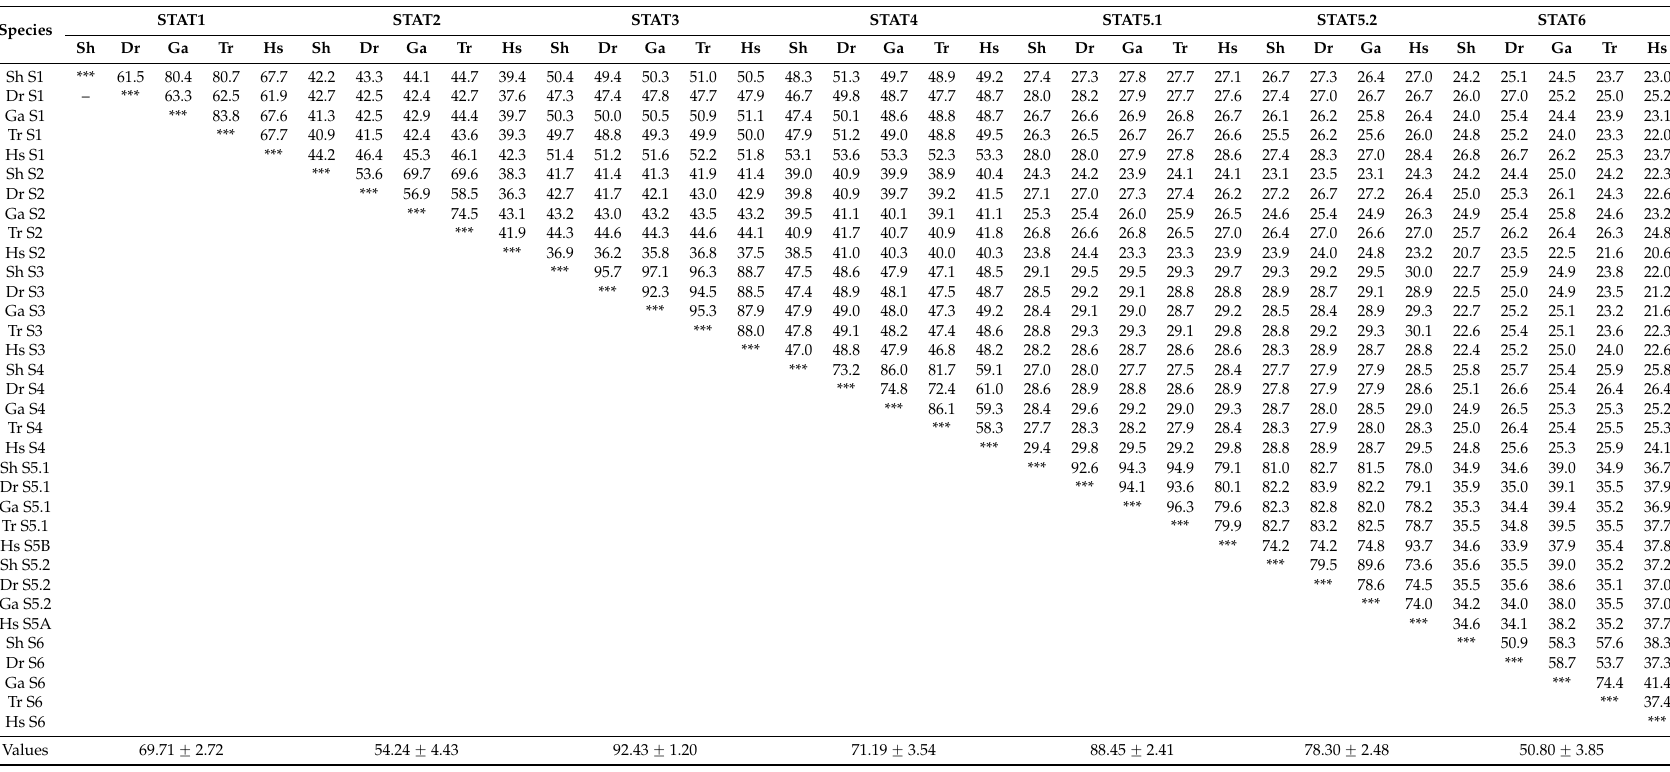
Table 2. Amino acid sequence identity of STAT between different species (%) (Sh, Dr, Ga, Tr and Hs mean S. hasta , Danio rerio , Gasterosteus aculeatus , Takifugu rubripes and Homo sapiens , respectively). Amino acid sequence identity of the same STAT isoform between species is shaded. Values in the bottom line represent the means ˘ SEM from identity of the same STAT